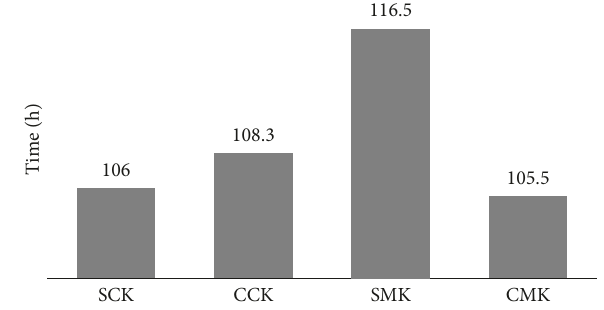
Figure 8: Time associated to the appearance of the outer race bearing fault.